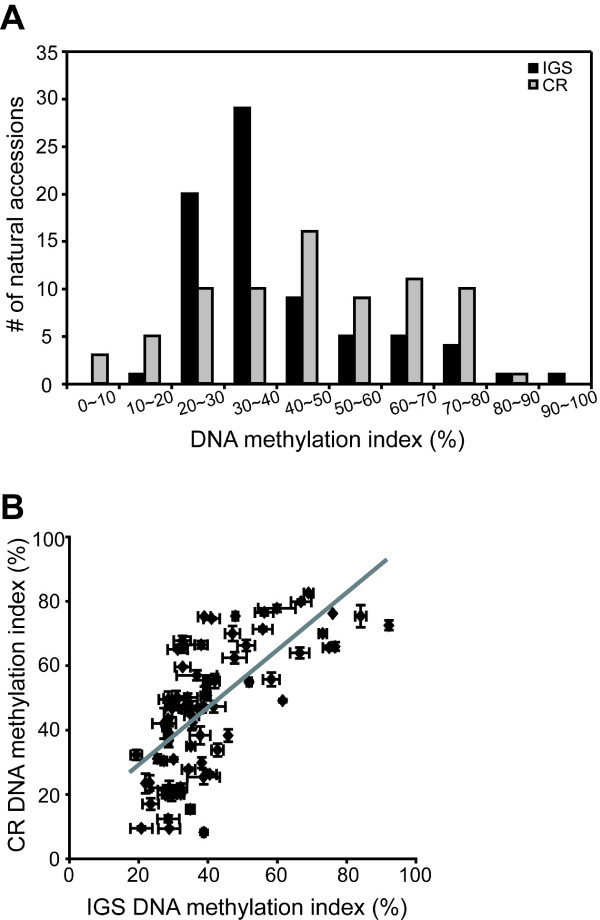
IGS DNA methylation in 45S rRNA gene repeats among Arabidopsis natural accessions. (A) Distributions of relative CR and IGS DNA methylation in 75 natural accessions. The frequency histograms show the range and distribution of CR and IGS DNA methylation in Arabidopsis natural accessions. (B) A correlation between CR DNA methylation and IGS DNA methylation. Means and standard errors were calculated from at least three independent experiments. The gray line is a linear regression of the data (linear regression coefficient, R = 0.68).